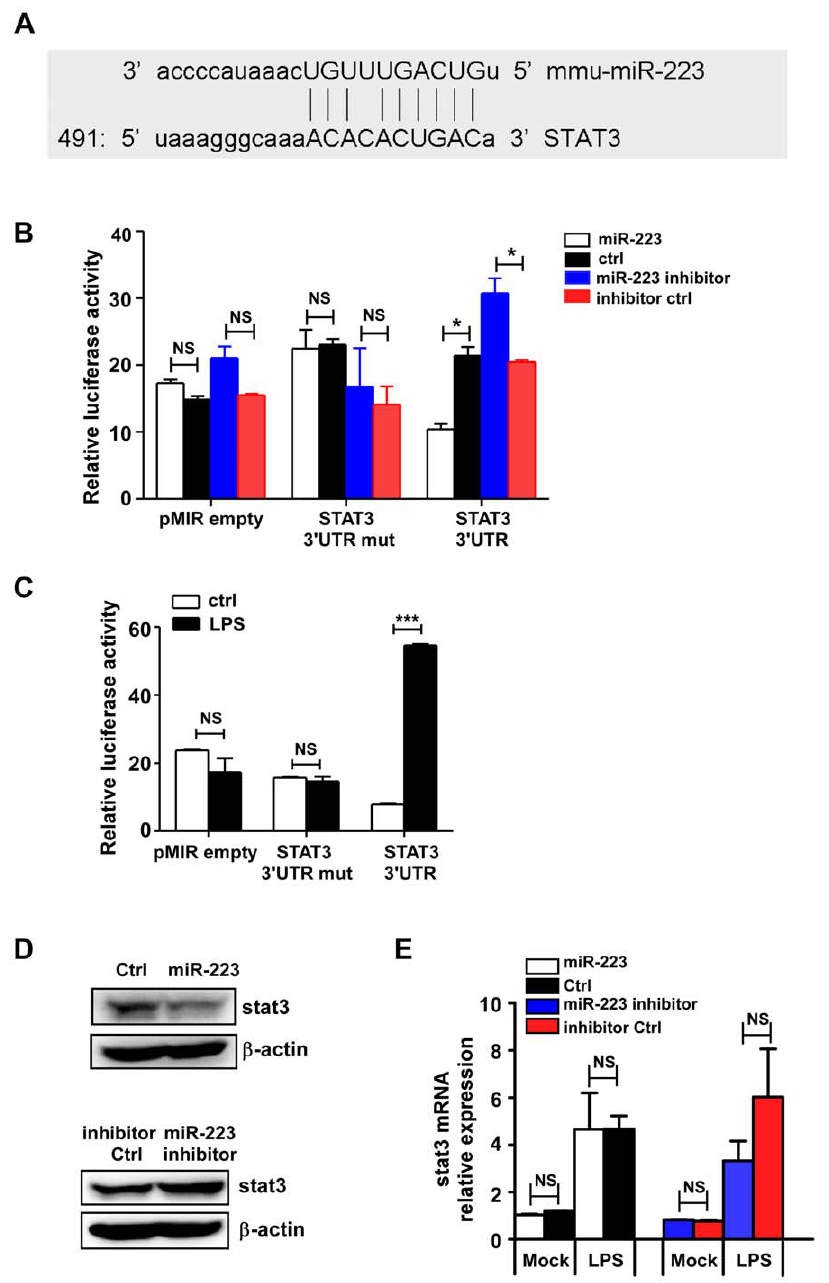
Figure 5. MiR-223 targets mouse STAT3 for translational inhibition but not mRNA degradation. (A) The alignment of miR223 and its target sites in 3 9 -UTR of STAT3 is shown. (B) RAW264.7 cells were cotransfected with pMIR-REPORT TM -STAT3-3 9 UTR luciferase reporter plasmid, STAT3- 3 9 -UTR-mutant or empty pMIR-REPORT TM and pTK-RL plasmid, together with miR-223 mimics or inhibitors (30 nM). After 24 h, firefly luciferase activity was measured and normalized by Renilla luciferase activity. (C) RAW264.7 cells were transfected with the pMIR-REPORT TM STAT 3 9 UTR, STAT 3 9 UTR mutant and control plasmids. Luceferase activity in cells with or without LPS stimulation was measured. (D) RAW264.7 cells were transfected mimics or inhibitors of miR-223 and their controls (30 nM). After 24 h, STAT3 protein expression was detected by immunoblotting. b -actin served as a loading control. The data shown represent three independent experiments. (E) RAW264.7 cells were transfected with mimics or inhibitors of miR-223 and their controls, 24 h later, STAT3 mRNA levels were determined with or without LPS at 12 h post stimulation. *** p , 0.001; * p , 0.05; NS, not significant. Data are the mean 6 SD (n=3) of one representative experiment. Similar results were obtained in three independent experiments. doi:10.1371/journal.pone.0042971.g005 cell surface [33]. In both scenarios, IL-6 exerts its action via the versus trans-signaling in regulating the TLR-driven inflammatory signal transducers gp (glycoprotein) 130, leading to the activation responses. The use of IL-6 instead of LPS or poly (I:C) induced a of the JAK/STAT and MAPK cascades [32]. In this study, we quicker down-regulation of miR-223 expression. To further demonstrated that miR-223 may be involved in the IL-6 classical investigate the molecular mechanisms underlying the IL-6/miR-